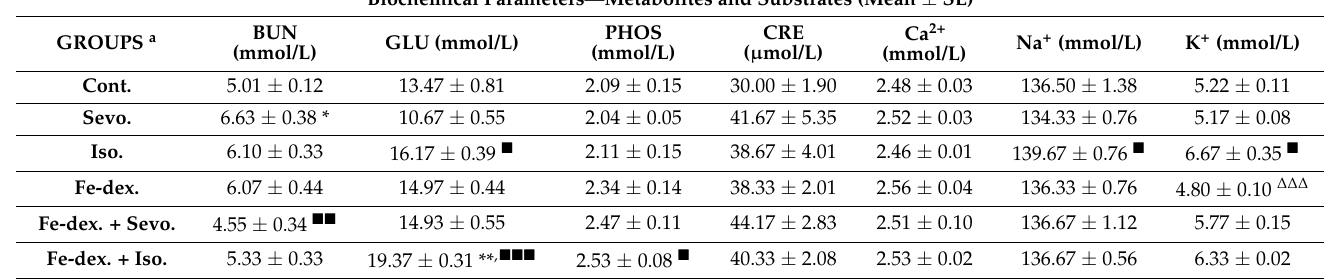
Table 2. Biochemical values of metabolites and substrates from blood of rats treated with inhaled anesthetics and iron dextran and their